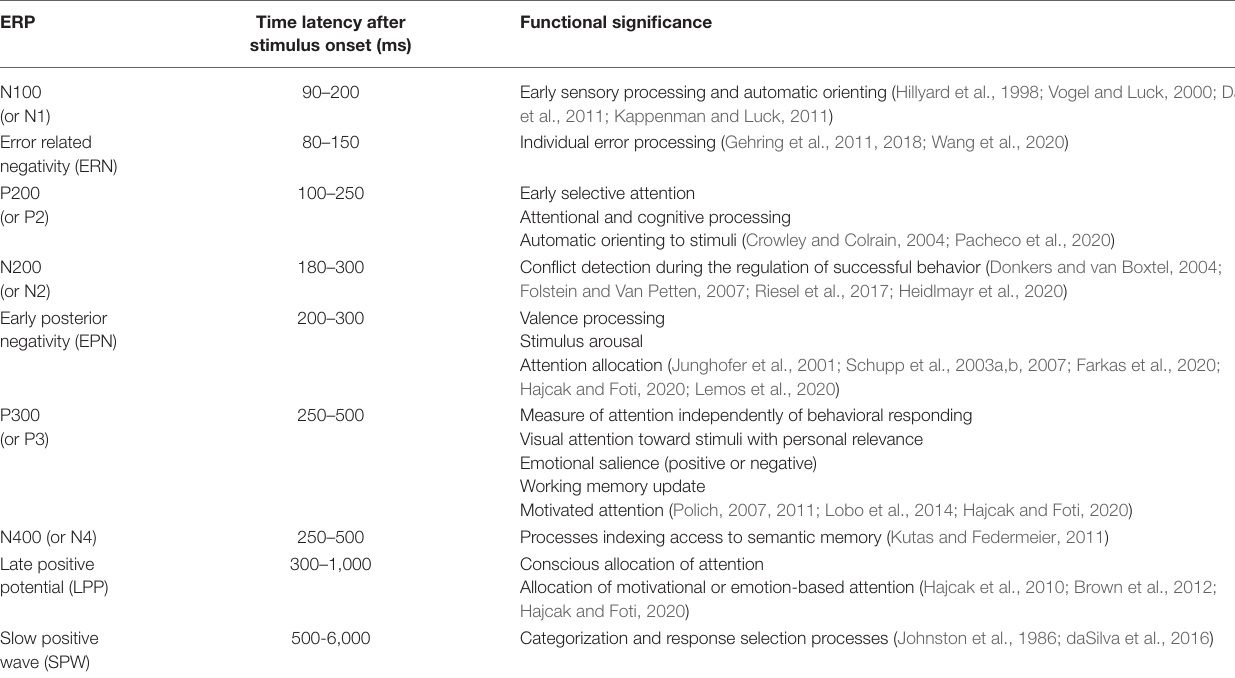
TABLE 1 | ERP components by time latency and functional significance.